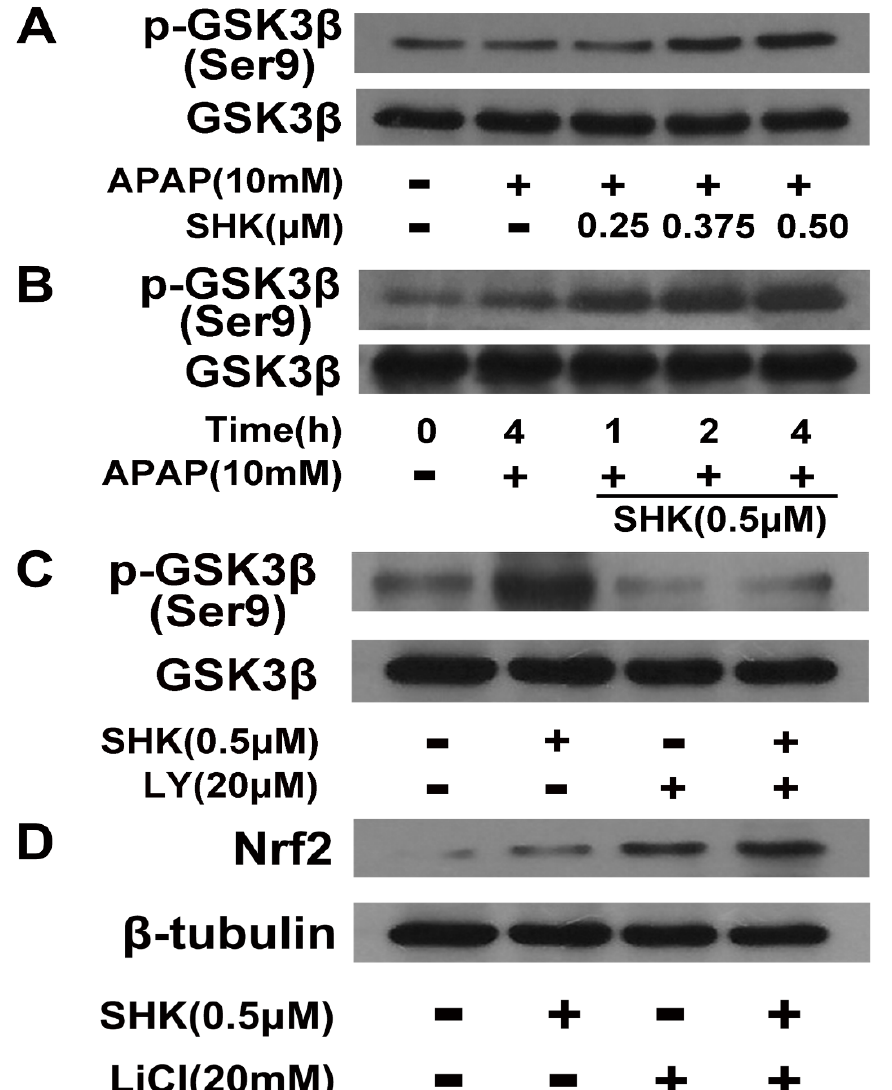
Figure 6. Effect of SHK on Akt-induced GSK3 β phosphorylation and Nrf2 upregulation. ( A , B ) L-02 cells were incubated with SHK for the indicated durations, and then the levels of GSK3 β phosphorylation were evaluated by Western blotting. ( C ) L-02 cells were pretreated with LY294002 (20 µ M) for 1 h, followed by treatment with SHK for 4 h, and GSK3 β protein and phosphorylated GSK3 β levels were evaluated by Western blotting. ( D ) L-02 cells were pretreated with lithium chloride (20 mM) for 4 h, followed by treatment with SHK for 4 h, and GSK3 β protein and phosphorylated GSK3 β levels were evaluated by western blotting.